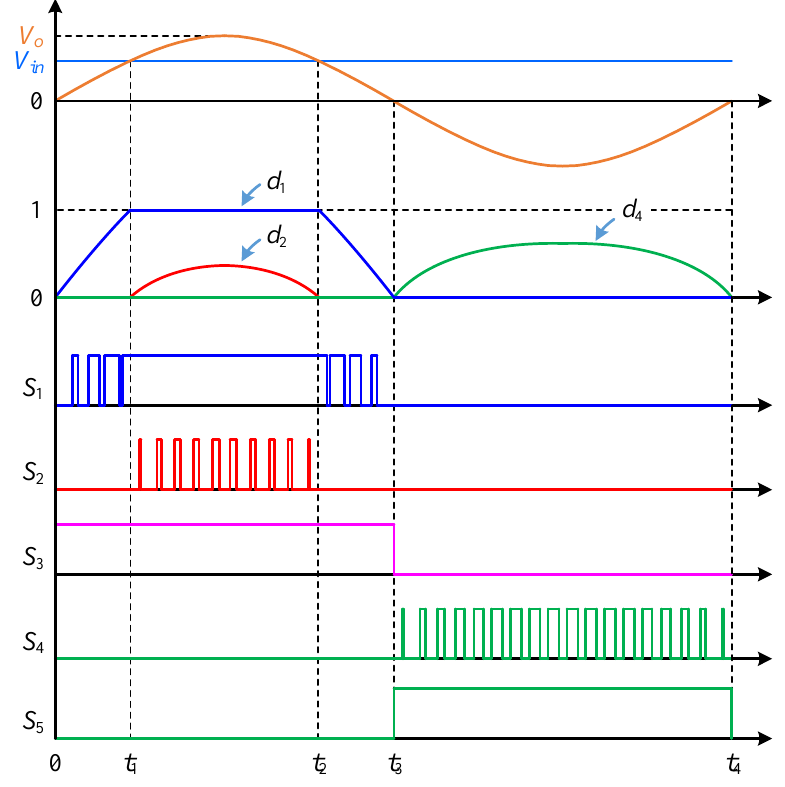
Figure 2. PWM control method of the proposed CGBBI topology.